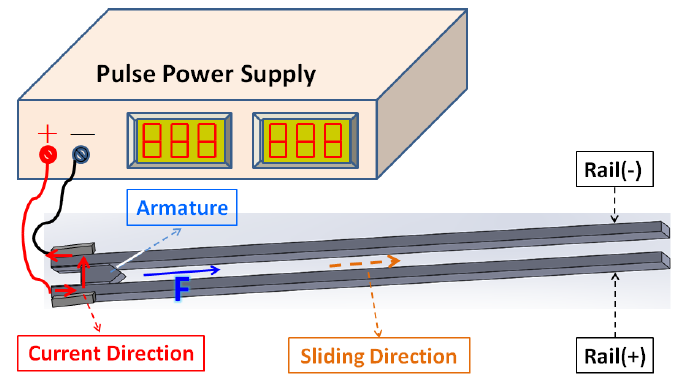
Figure 1. Schematic diagram of electromagnetic rail catapult.